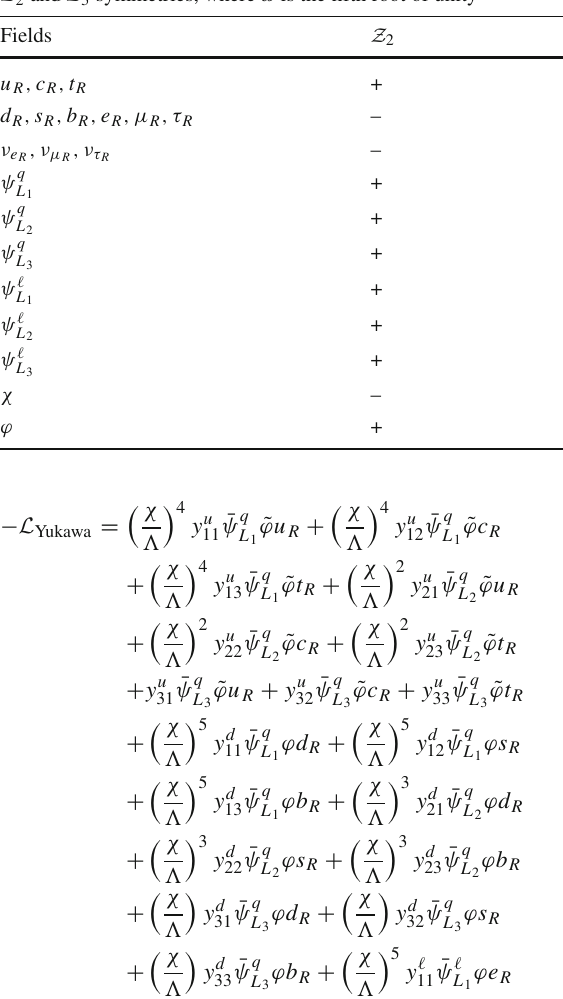
Table4 Thechargesofleftandright-handedfermionsofthreefamilies oftheSM,right-handed neutrinos, Higgs,andsingletscalarfieldsunder Z Z 2 and 5 symmetries, where